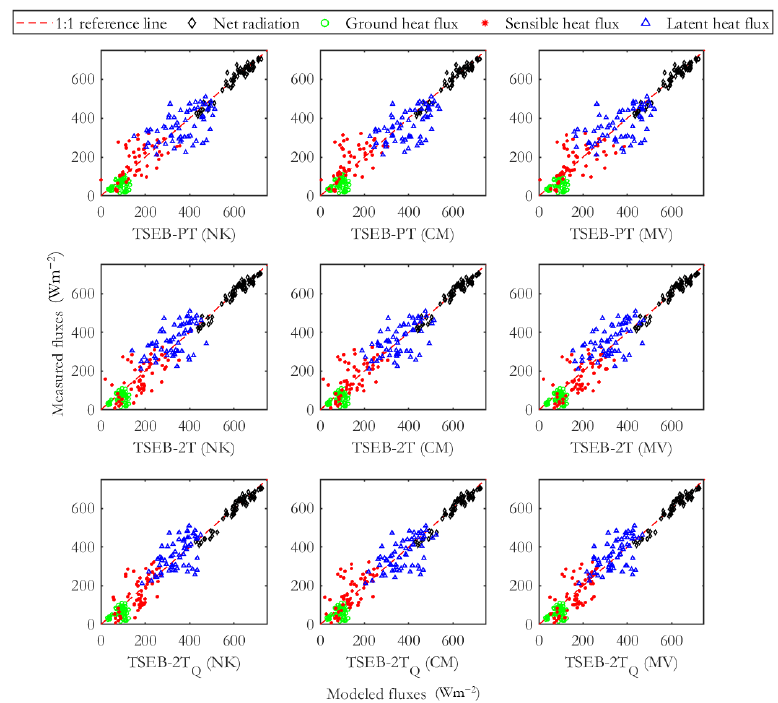
Figure 5. Scatter plots showing the comparison between energy balance components measured from the EC flux tower (y-axis) and the modeled energy balance components from TSEB-PT, TSEB-2T, and TSEB-2T Q (rows 1–3) using the NK, CM and MV (columns 1–3) resistance formulations (x-axis). Statistical metrics of evaluation for each flux, model, and resistance formulation are provided in Table 1. Statistics show that the modeled Rn from different TSEB models, in general, has a good agreement with the Rn from the EC flux tower. However, the modeled G calculated via the ratio of the modeled soil net radiation has a lower agreement with the G from the EC flux tower, which may result from the constant value (0.33) adopted for the time period from 10 am to 4 pm. This suggests that a time-varying ratio needs to be used for the G estimation, based on sUAS information for different times during the day, as suggested by Nieto et al., 2019 [27]. Sensible heat estimates from TSEB models coupled with the NK and/or the MV resistance models have better agreement with tower meas- urements as quantified by the index of agreement, d (Table 1). Based on the RMSE and d values, the H and LE estimated from the TSEB-2T Q shows better agreement with meas- urement fluxes. This shows that the QTS method considering shadow and extreme pixel- value effects, characteristics of the high-resolution pixel within the smallest TSEB model- ing domain, in general improved the flux estimation.